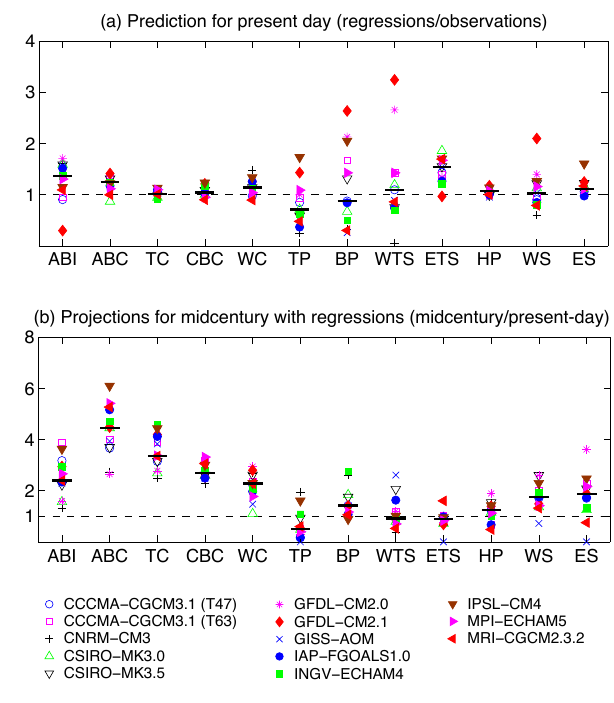
Figure 5. (a) Ratios of modeled to observed area burned for 1983–1999 and (b) the ratios of mid-century (2048–2064) to the present-day (1983–1999) area burned, as projected by an ensemble of GCMs. The ecoregions are: Alaska Boreal Interior (ABI), Alaska Boreal Cordillera (ABC), Taiga Cordillera (TC), Canadian Boreal Cordillera (CBC), Western Cordillera (WC), Taiga Plain (TP), Boreal Plain (BP), Western Taiga Shield (WTS), Eastern Taiga Shield (ETS), Hudson Plain (HP), Western Mixed Wood Shield (WS), and Eastern Mixed Wood Shield (ES). Different symbols are used for each model. The black bold lines indicate the median ratios. Note the difference in scale between the two panels.